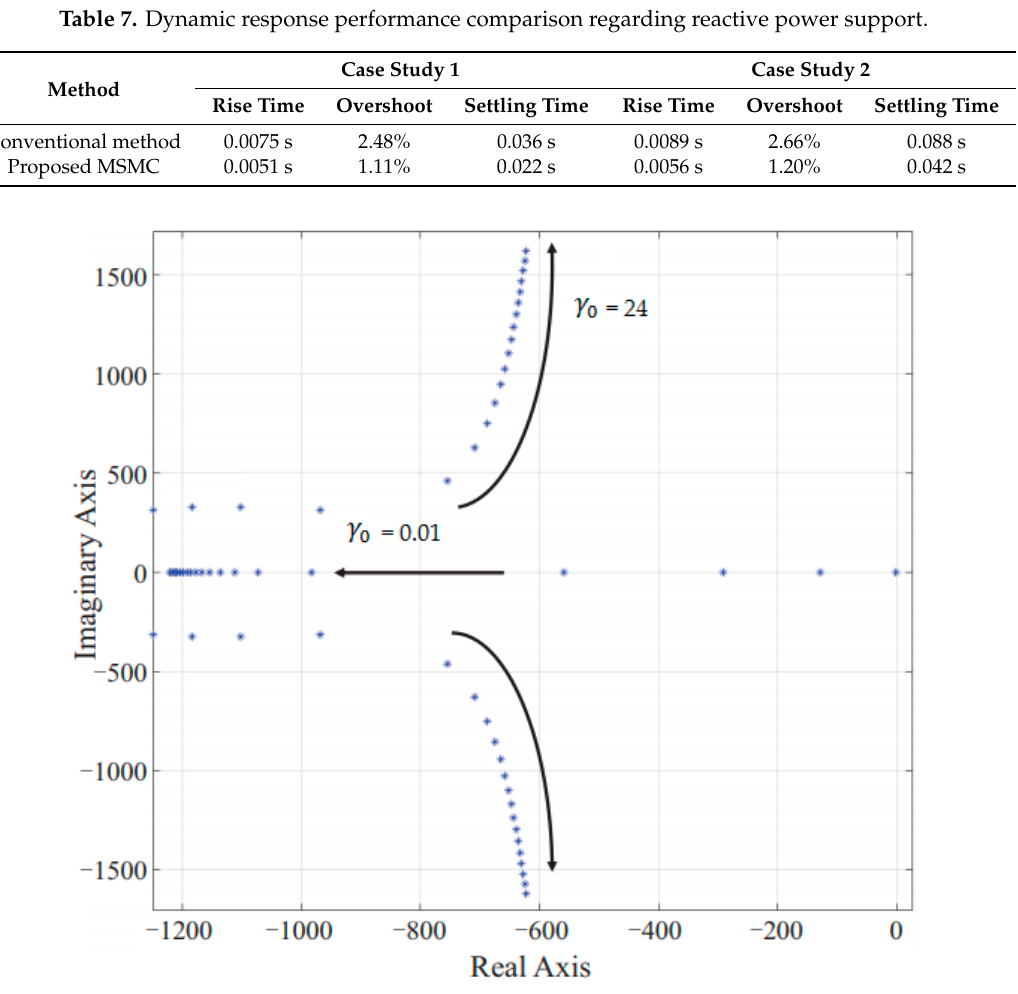
Figure 11. The root-locus diagram of control system poles.